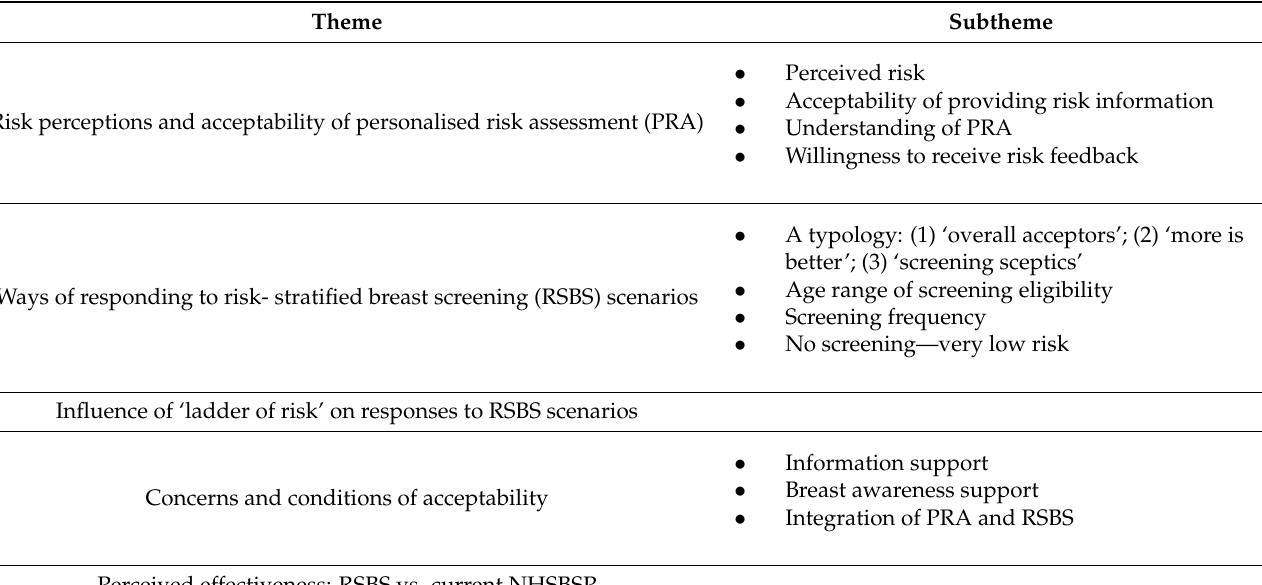
Table 2. Summary of themes and